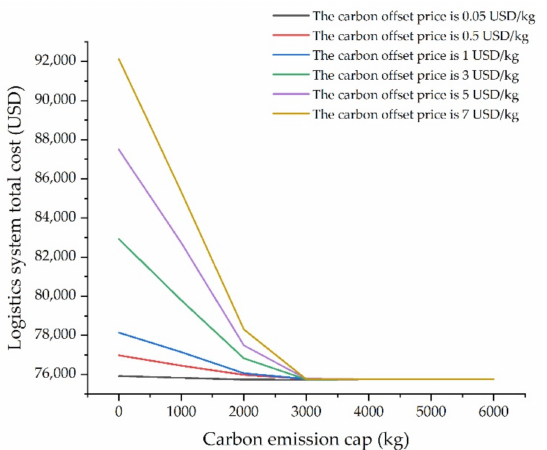
Figure 17. The relationship between total logistics cost and carbon offset price and carbon emission caps in the logistics system.